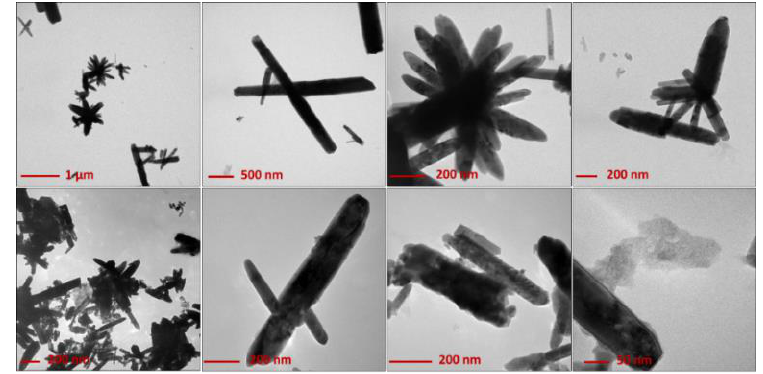
Figure 2. TEM images of electrosynthesized ZnO-based materials in the presence of poly-diallyl- (dimethylammonium) chloride (PDDA). Upper panels: ZnO dried at 120 °C overnight; lower panels: ZnO calcined at 450 °C for 1 h.